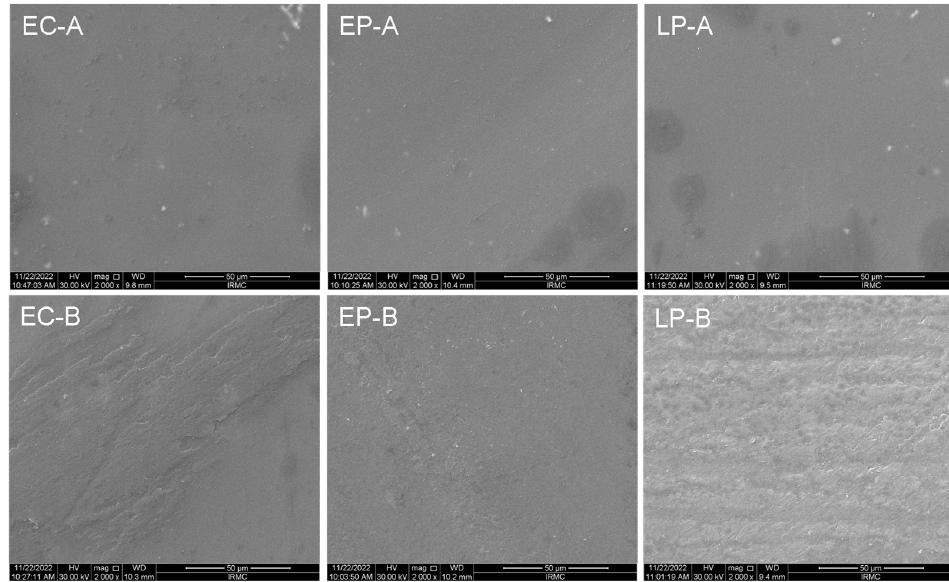
Figure 1. SEM images of the CAD/CAM specimens before (EC-A, EP-A, and LP-A) and after ce-